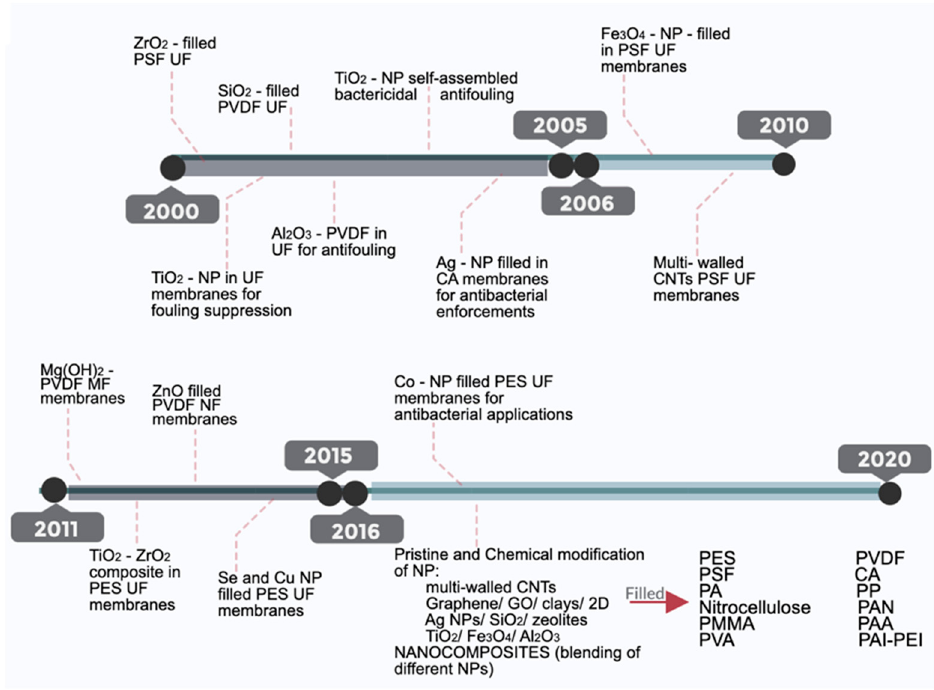
Figure 5. Milestones showing the progress of the nanocomposite membranes over the last 20 years.